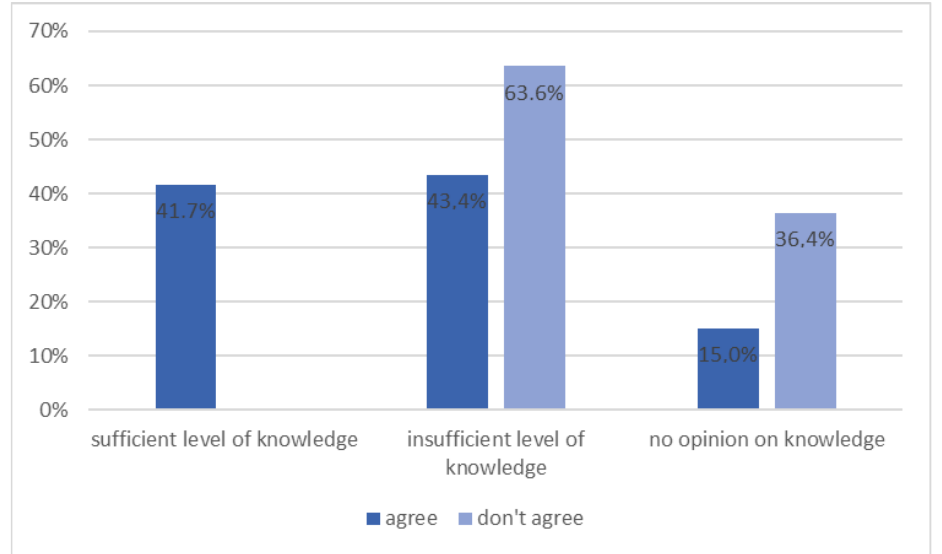
Figure 7. Patients’ opinion on proper eating habits in preventing the development of diabetes depending on their self-assessment of knowledge about diabetes ( n = 131, p = 0.003).